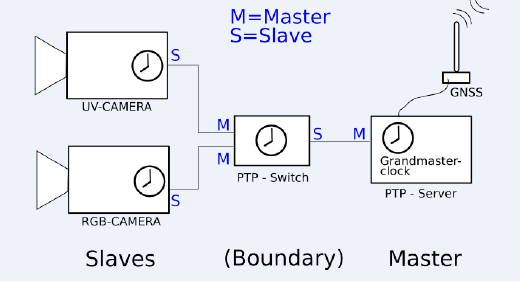
Figure 1. PTP Synchronization scheme Each frame capture gets triggered by a pre-calculated timestamp of the internal clock, which is periodically syn- chronized to the GPS Time in order to correct the drifts of the internal clocks. Because the cameras get triggered at a specific GPS-timestamp and the flight data also is refer- enced to this time, both data streams can be interpolated afterwards in order to enable photogrammetric processing.